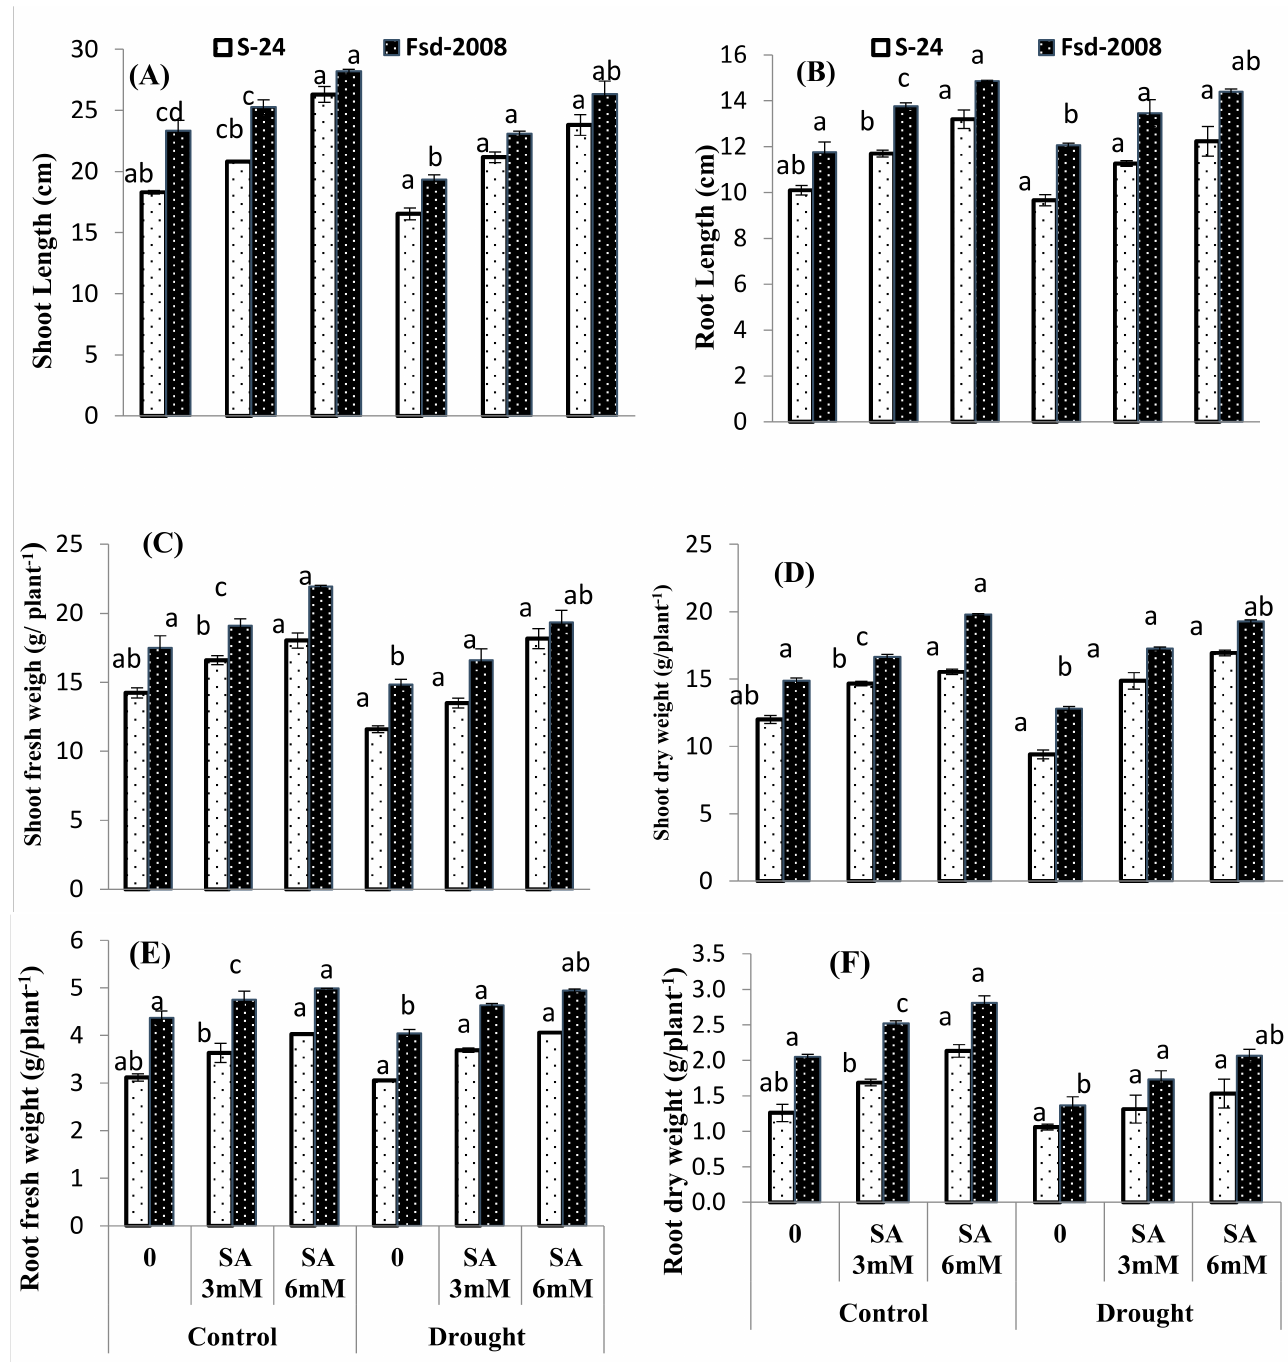
Figure 1. Effect of foliar-application of salicylic acid on ( A ) shoot length, ( B ) root length, ( C ) shoot fresh weight, ( D ) scheme 0., FSD-2008 ( E ) and SD-24 ( F ) Error bars above the means indicate standard errors ( n = 3). Drought stress decreased the shoot length of wheat by 9.65% and 17.14%, root length by 4.29% and 2.54%, shoot dry weight by 21% and 13%, and root dry weight by 15. 87% and 33.34% in S-24 and FSD-2008, respectively. Under drought stress, treatment with 6